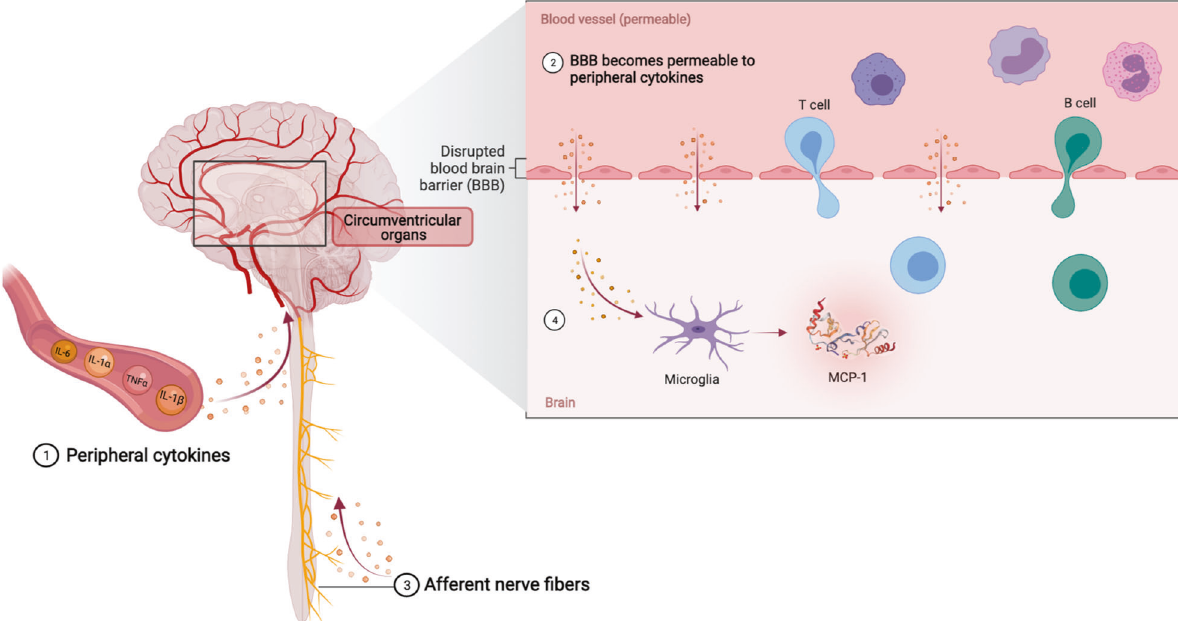
Fig. 3 Traf fi cking of peripheral in fl ammatory signals to brain. (1) Active transport of peripheral cytokines. (2) Passage of peripheral cytokines through leaky regions of blood – brain barrier (BBB). (3) Transmission of peripheral cytokine signals to the brain by activated cytokine receptors on afferent nerve fi bers. (4) Traf fi cking of peripheral cell types (e.g., monocytes, macrophages, and T cells) in response to monocyte chemoattractant protein (MCP-1) release by activated